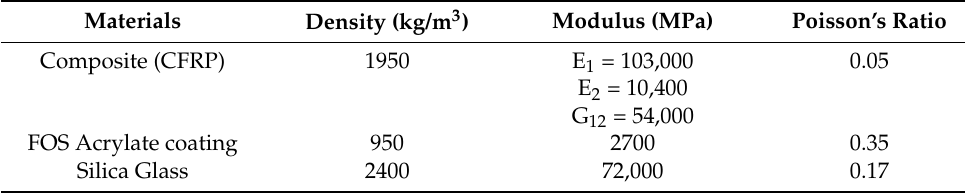
Table 1. Properties of the materials used in the article [1].